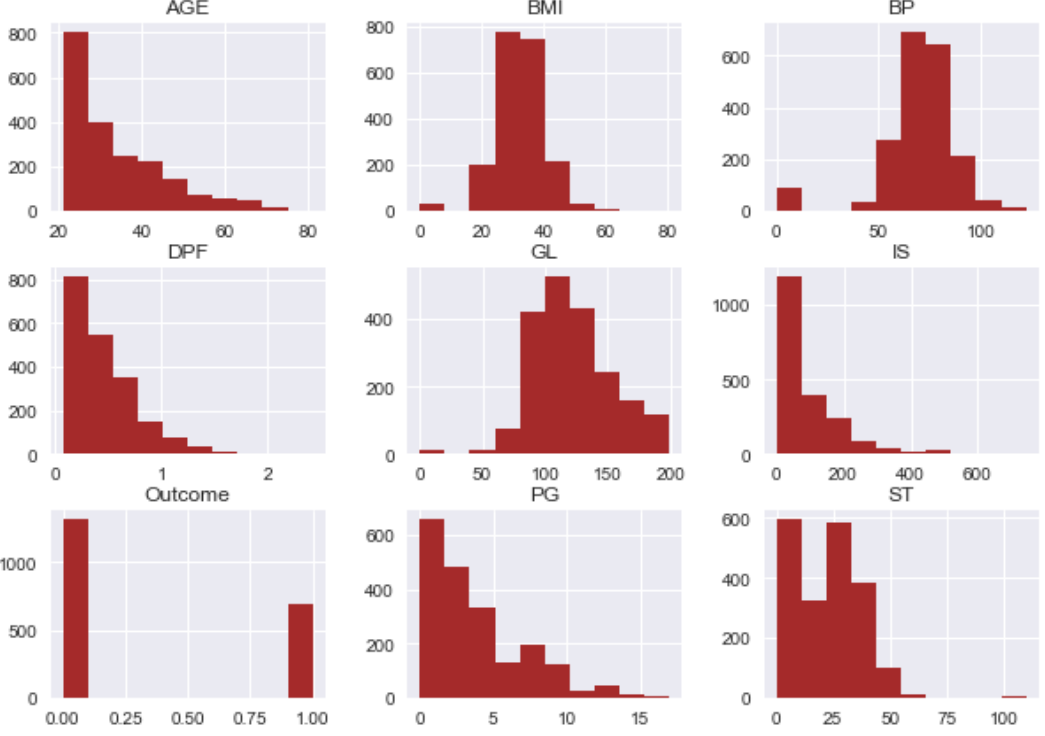
Figure 3. Histograms for the visual representation of features.